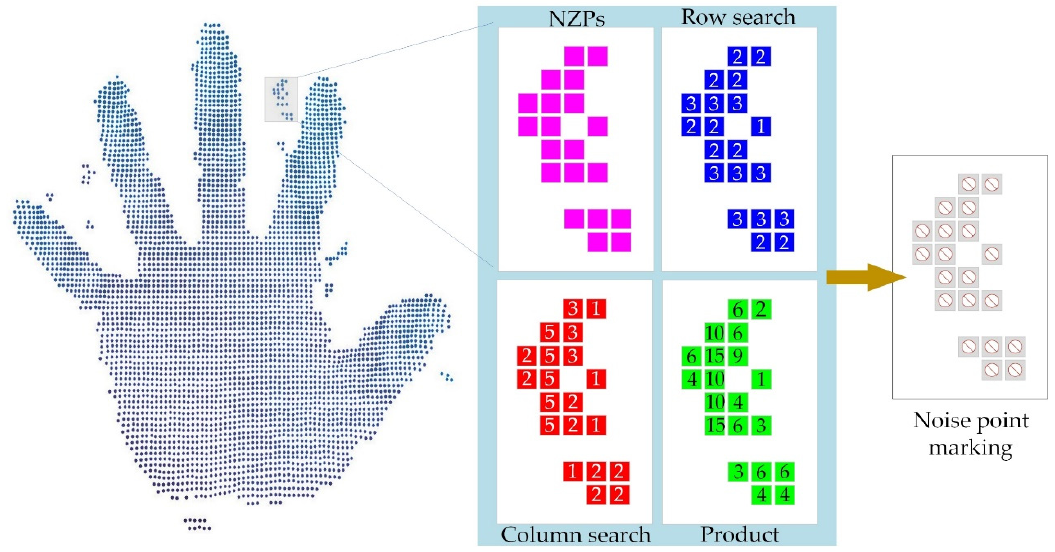
Figure 7. Orthogonally detecting the number of consecutive non-zero points of p . Algorithm 2 Plaque Noise Area Detection